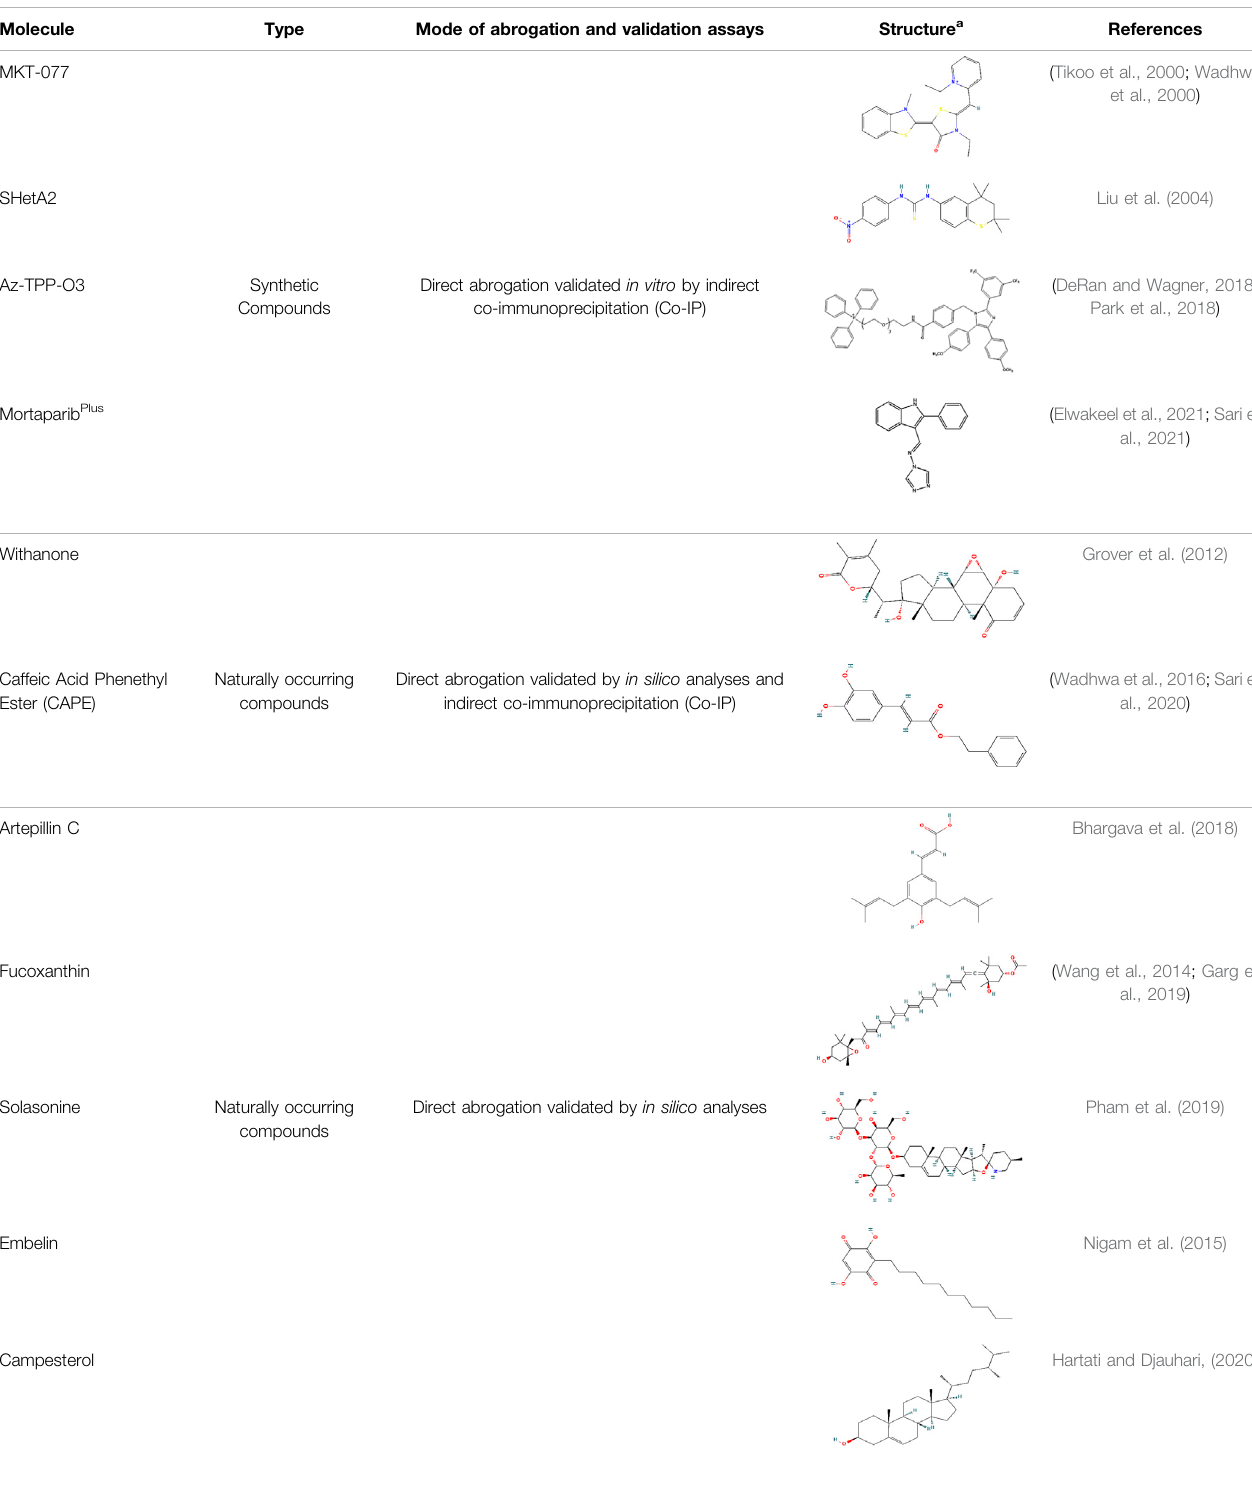
TABLE 1 | | Compounds that have been reported to abrogate the interaction between mortalin and